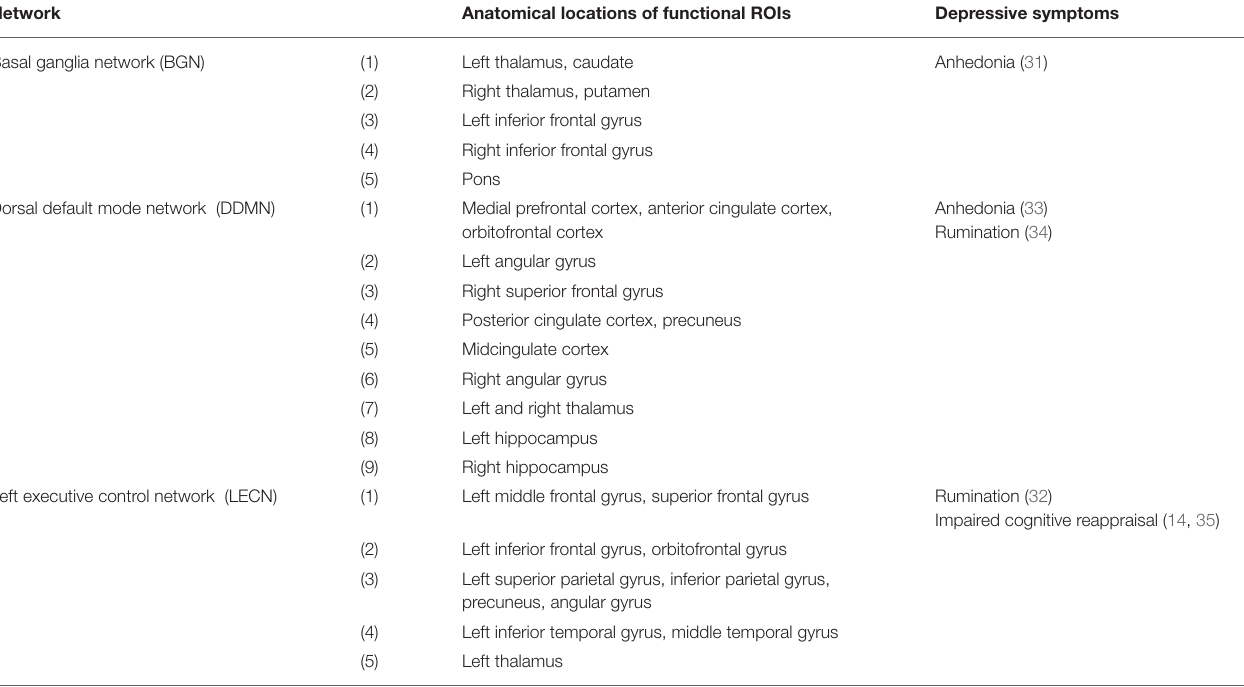
TABLE 3 | Functional brain networks associated with melancholic depression symptoms.